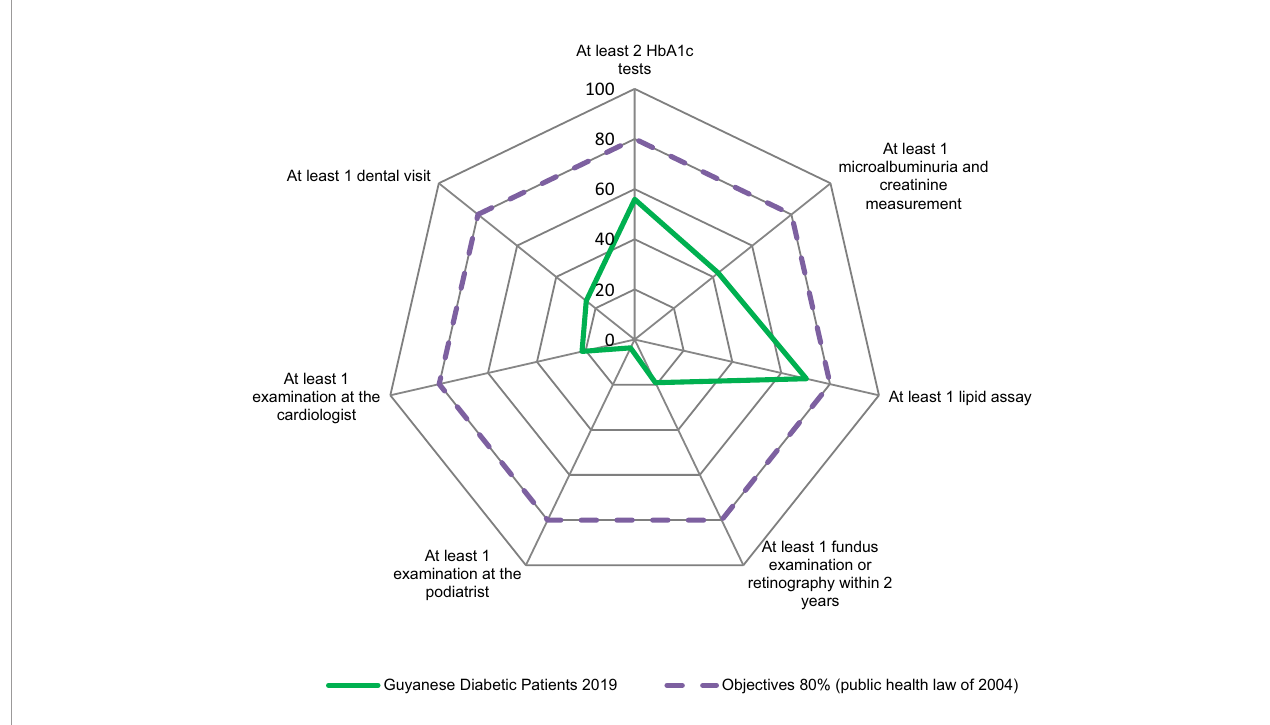
FIGURE 4 | Adequacy of follow-up of patients with diabetes in French Guiana compared to French